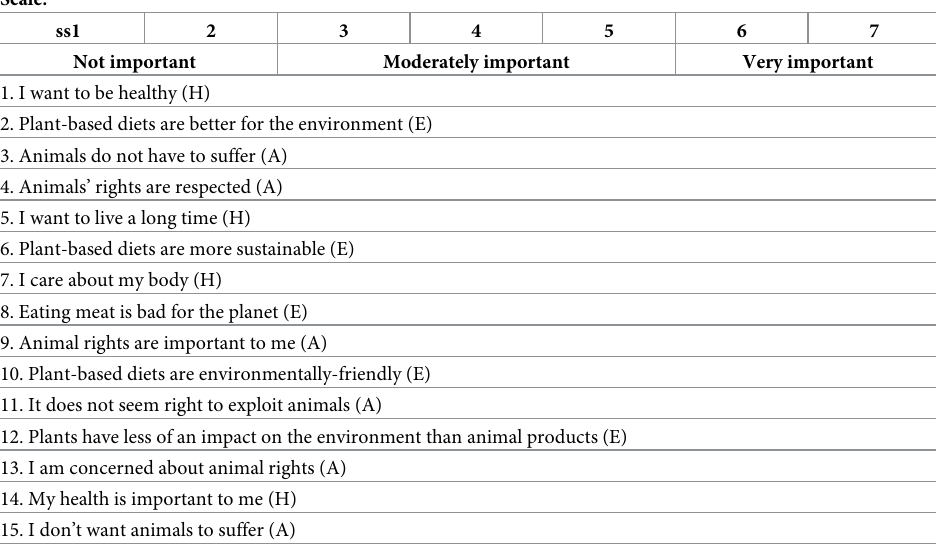
Table 1. Vegetarian Motives Inventory (VEMI). Please rate the importance of each of the following reasons for you to eat less meat or animal products. Please rate these items even if you don’t intend to change your diet.